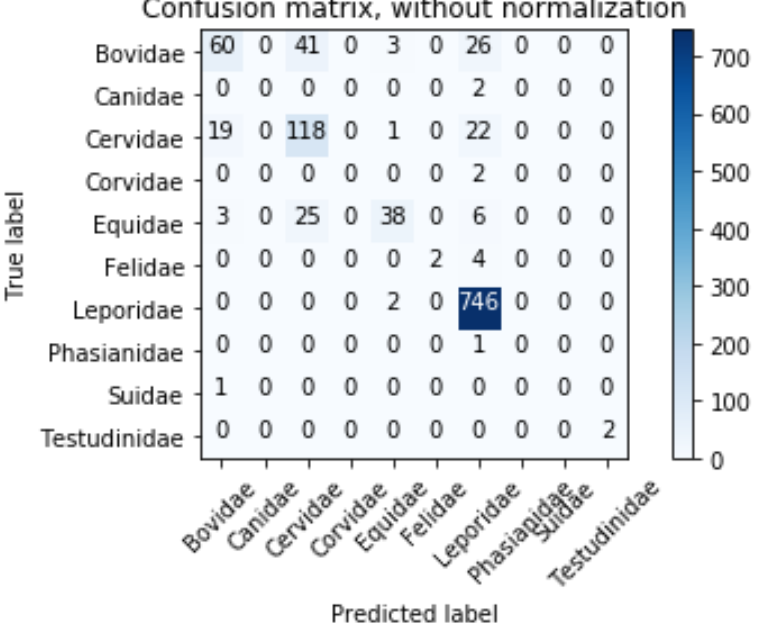
Figure 6. Confusion matrix of the fine